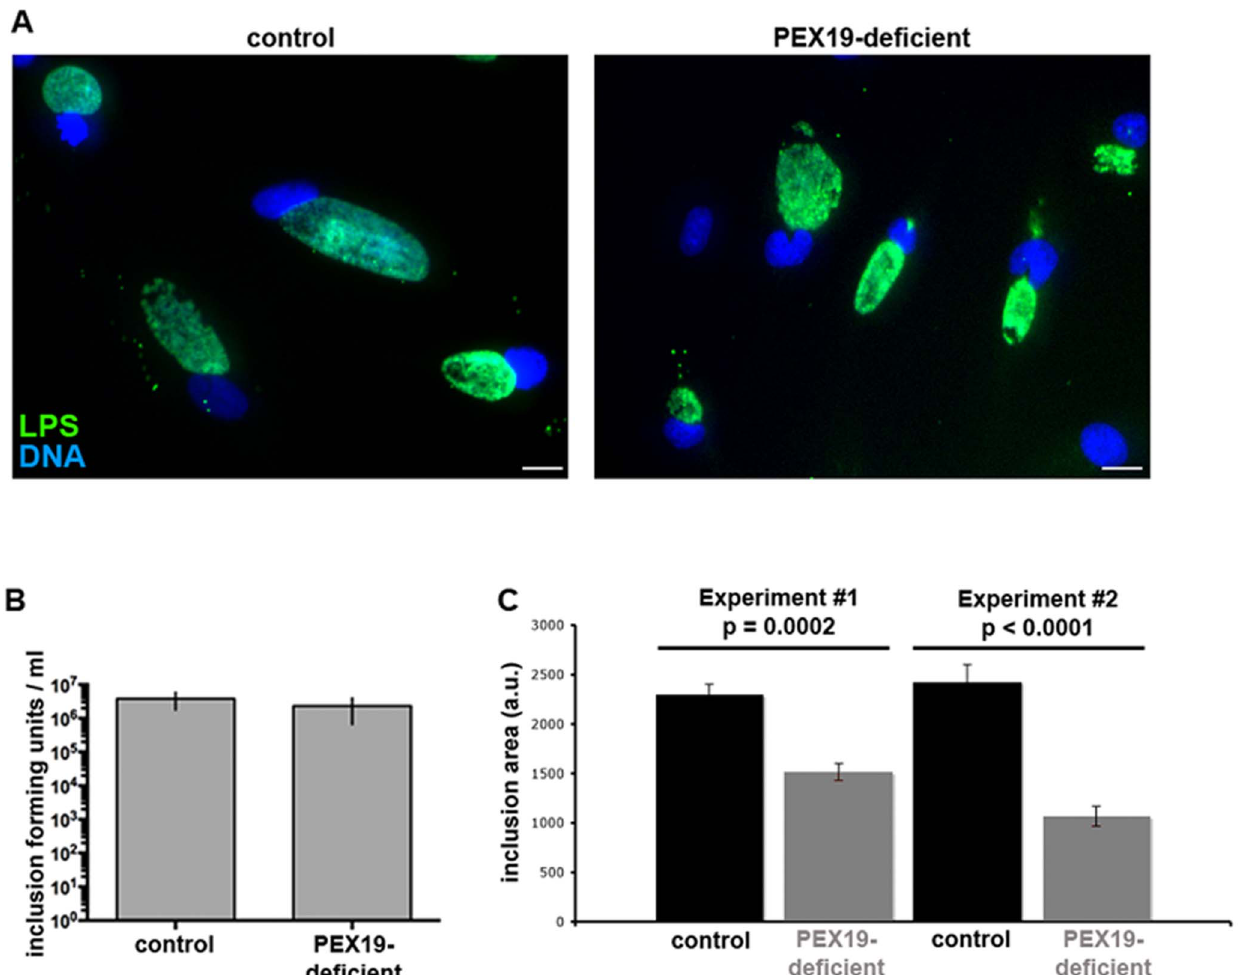
Figure 3. Peroxisomes are not essential for C.trachomatis infection and development. A- Control or PEX19-deficient fibroblasts were infected with C. trachomatis L2 for 24 h. Infected cells were fixed and labeled with an antibody against bacterial lipopolysaccharide (LPS) coupled to FITC (green) and DNA was stained with Hoechst (blue). Scale bar: 20 m m. B- The number of infection-forming units (IFU) was determined by titrating cell lysates at 48 hrs post infection on fresh HeLa cell monolayers. The average of three experiments is shown, error bars indicate standard deviation. C- Areas of inclusions. Results for two experiments are shown (Number of inclusions measured: experiment 1: control n=111, PEX19-deficient n=111; experiment 2: control n=65, PEX19-deficient n=76).